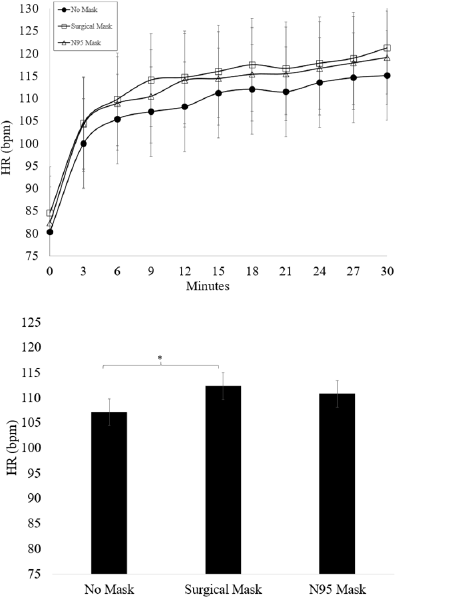
Figure 1. Average power output (mean ± SD) for each testing condition ( n = 19).